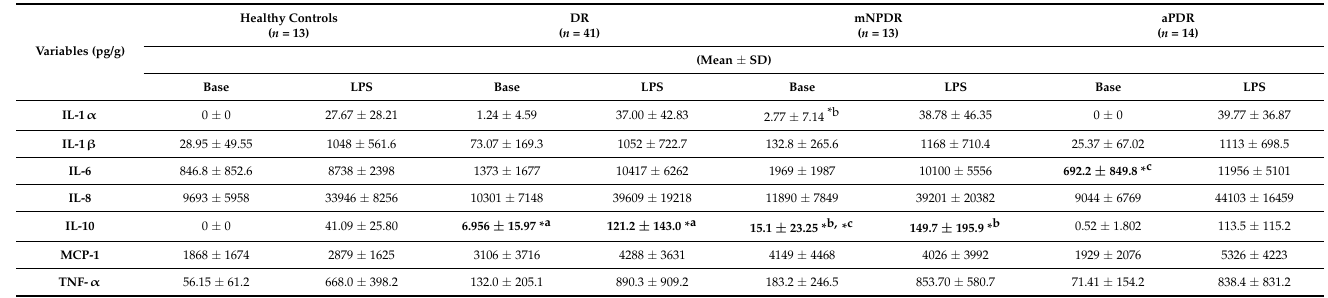
Table 2. Cytokine levels of supernatants from PBMCs with or without LPS